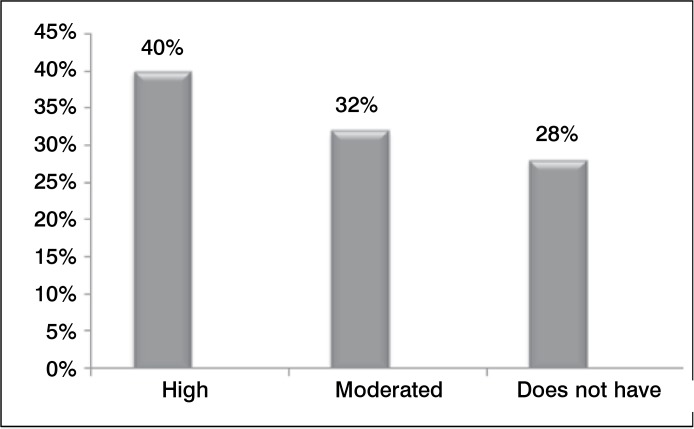
Relative frequency of fear of falling again.